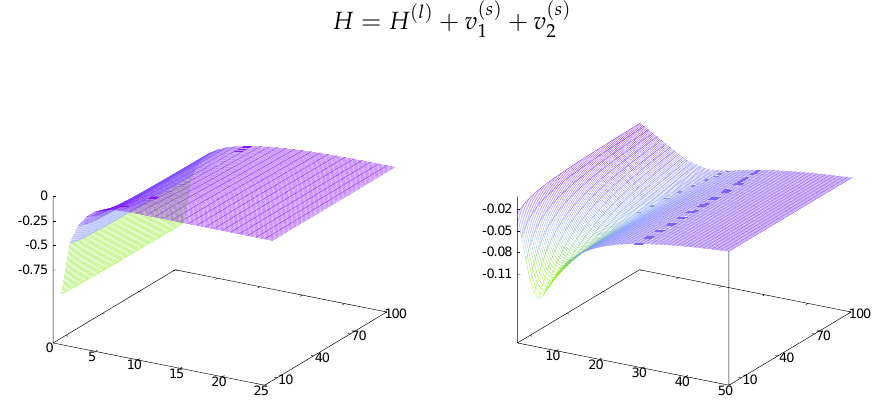
Figure 1. Short range ( v ( s ) ) and long range ( v ( l ) ) parts of an attractive Coulomb potential. The parameters are Z = − 1, x 0 = 4, y 0 = 12 and ν = 2.1.